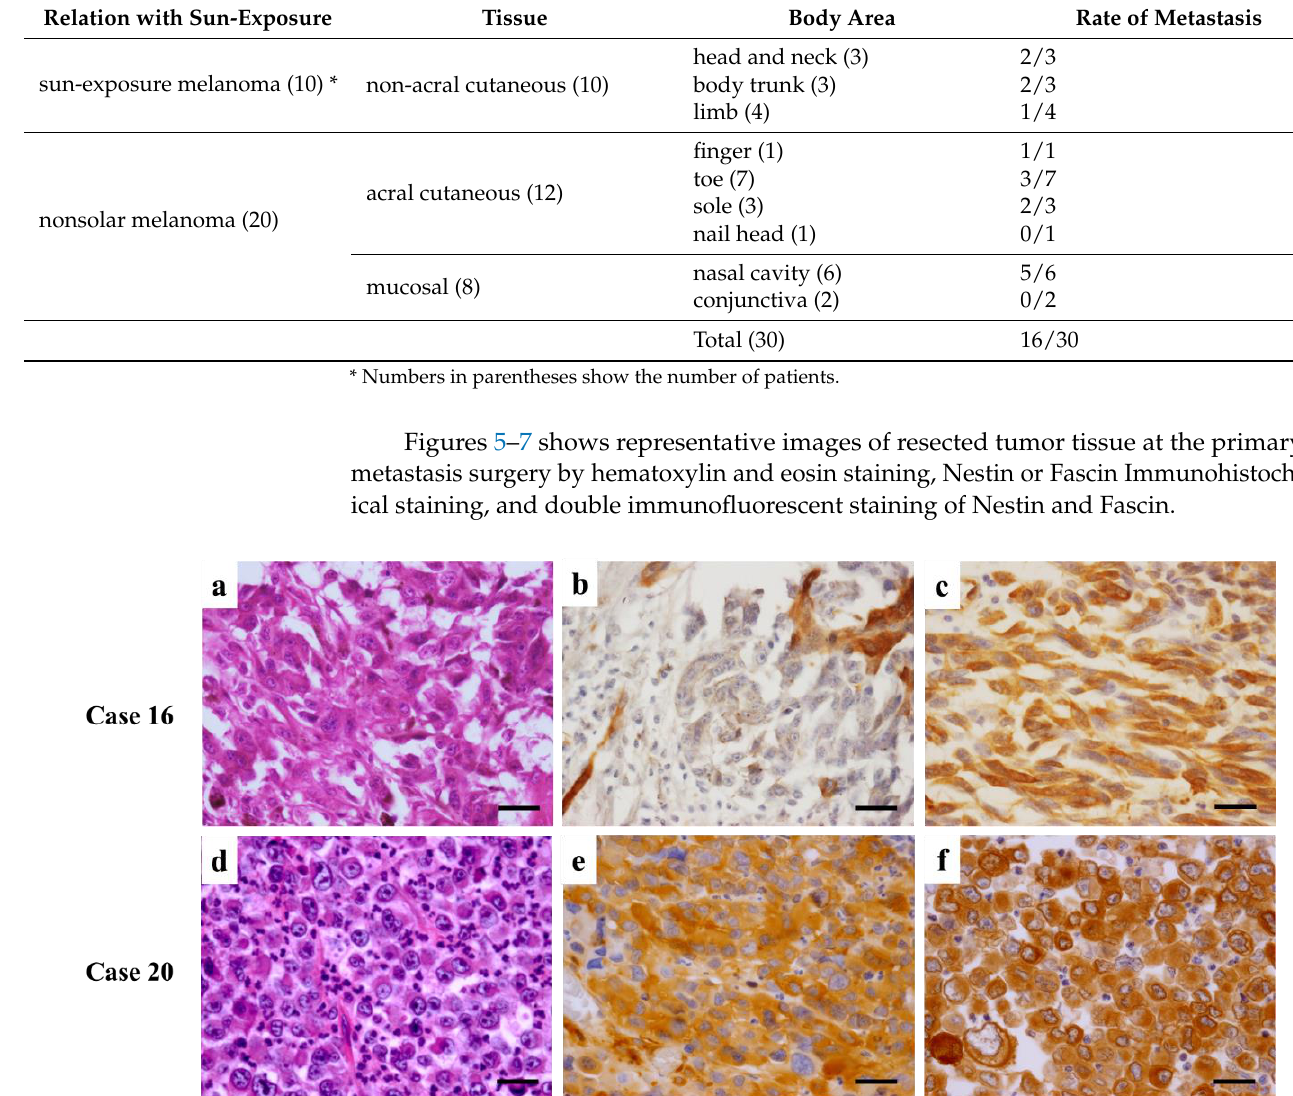
Table 5. Tumor locations classified according to the WHO categories.